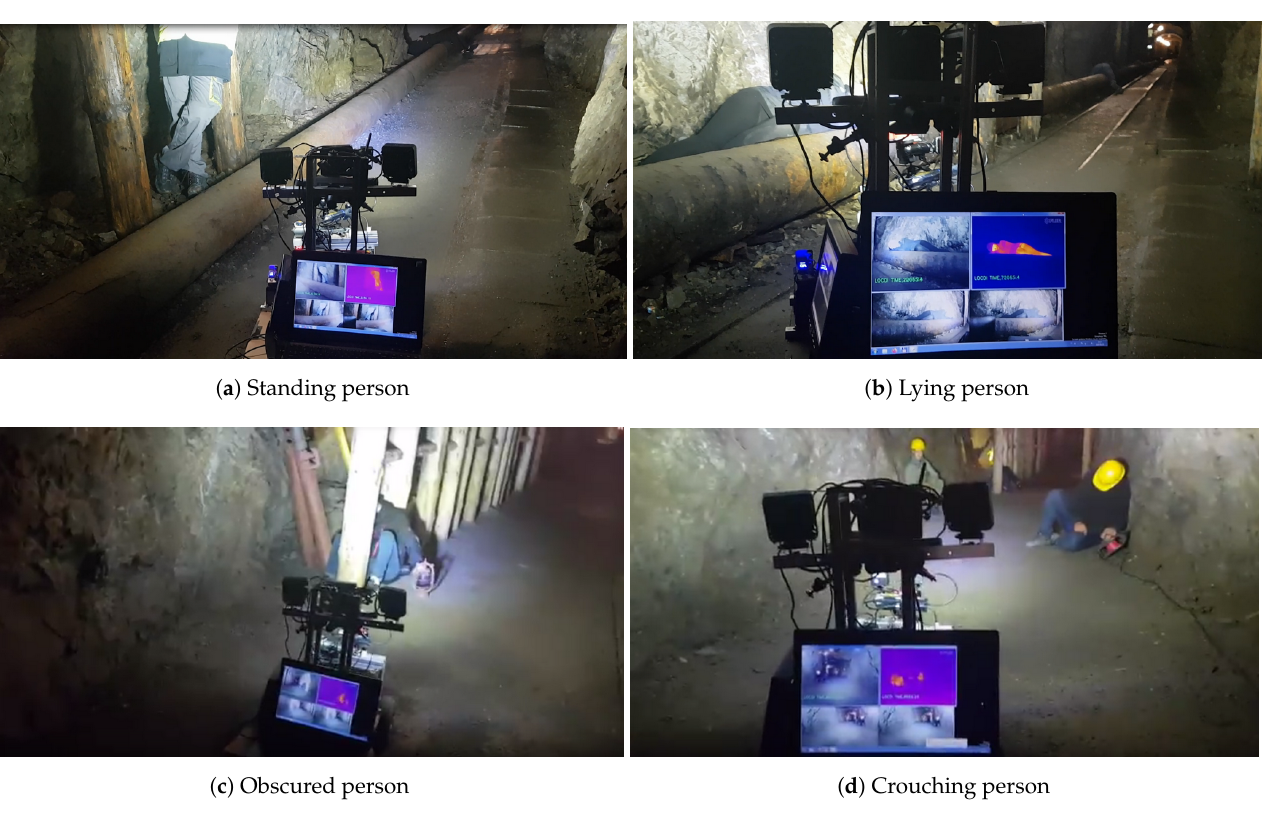
Figure 8. Exemplary scenarios of